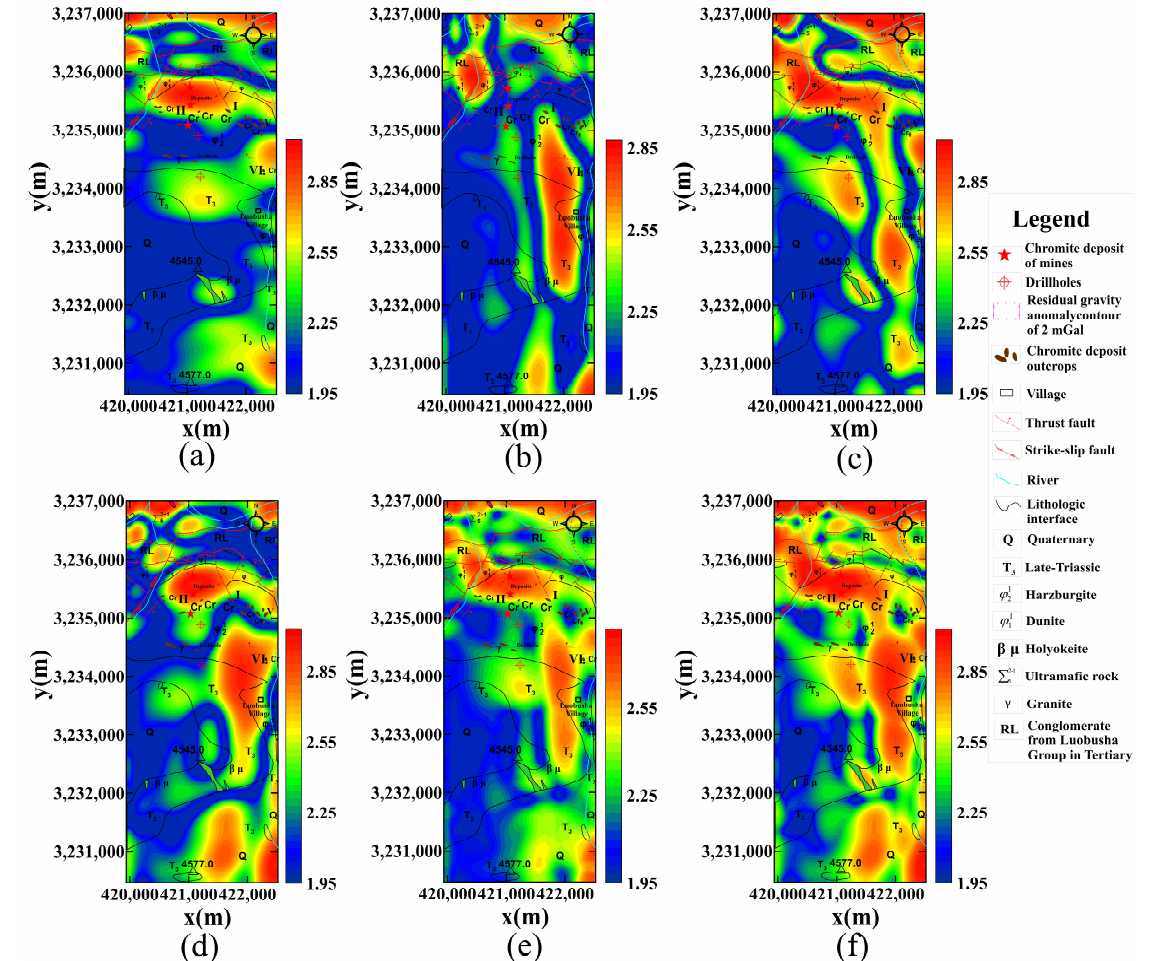
Figure 8. Fractal dimension results of the research area. ( a ) S-N direction; ( b ) W-E direction; ( c ) WN- SE direction; ( d ) NE-SW direction; ( e ) the maximum fractal dimension; ( f ) the average fractal di- mension.